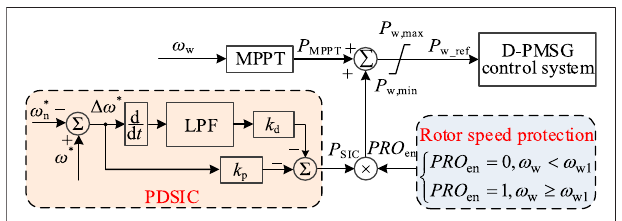
FIGURE 1 | Schematic diagram of